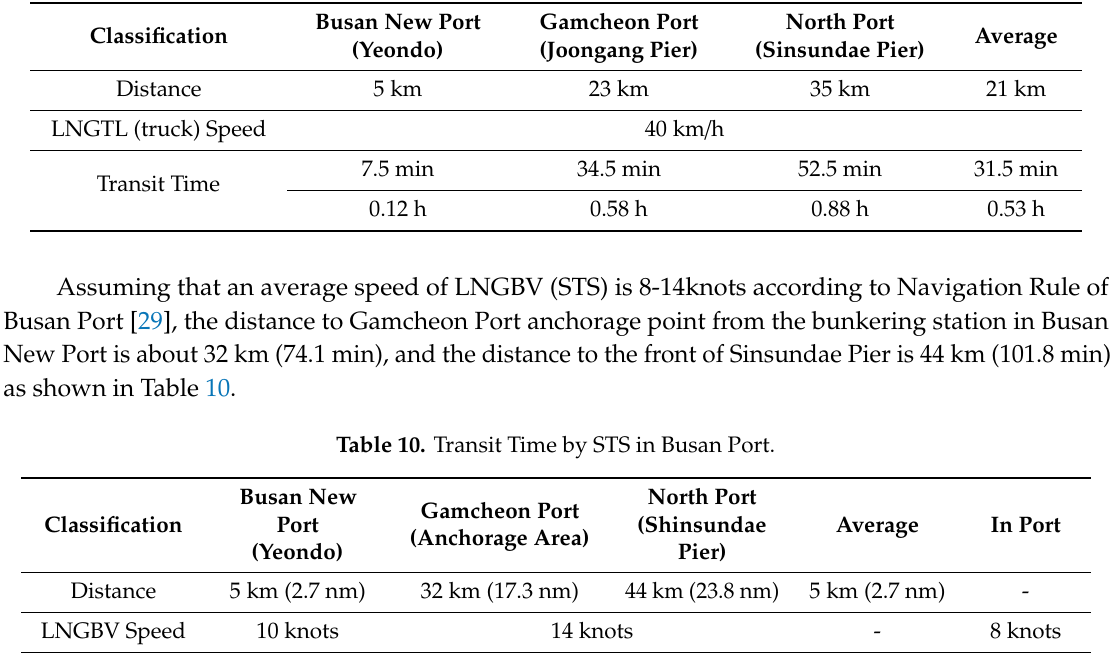
Table 9. Transit Time by TTS in Busan Port.